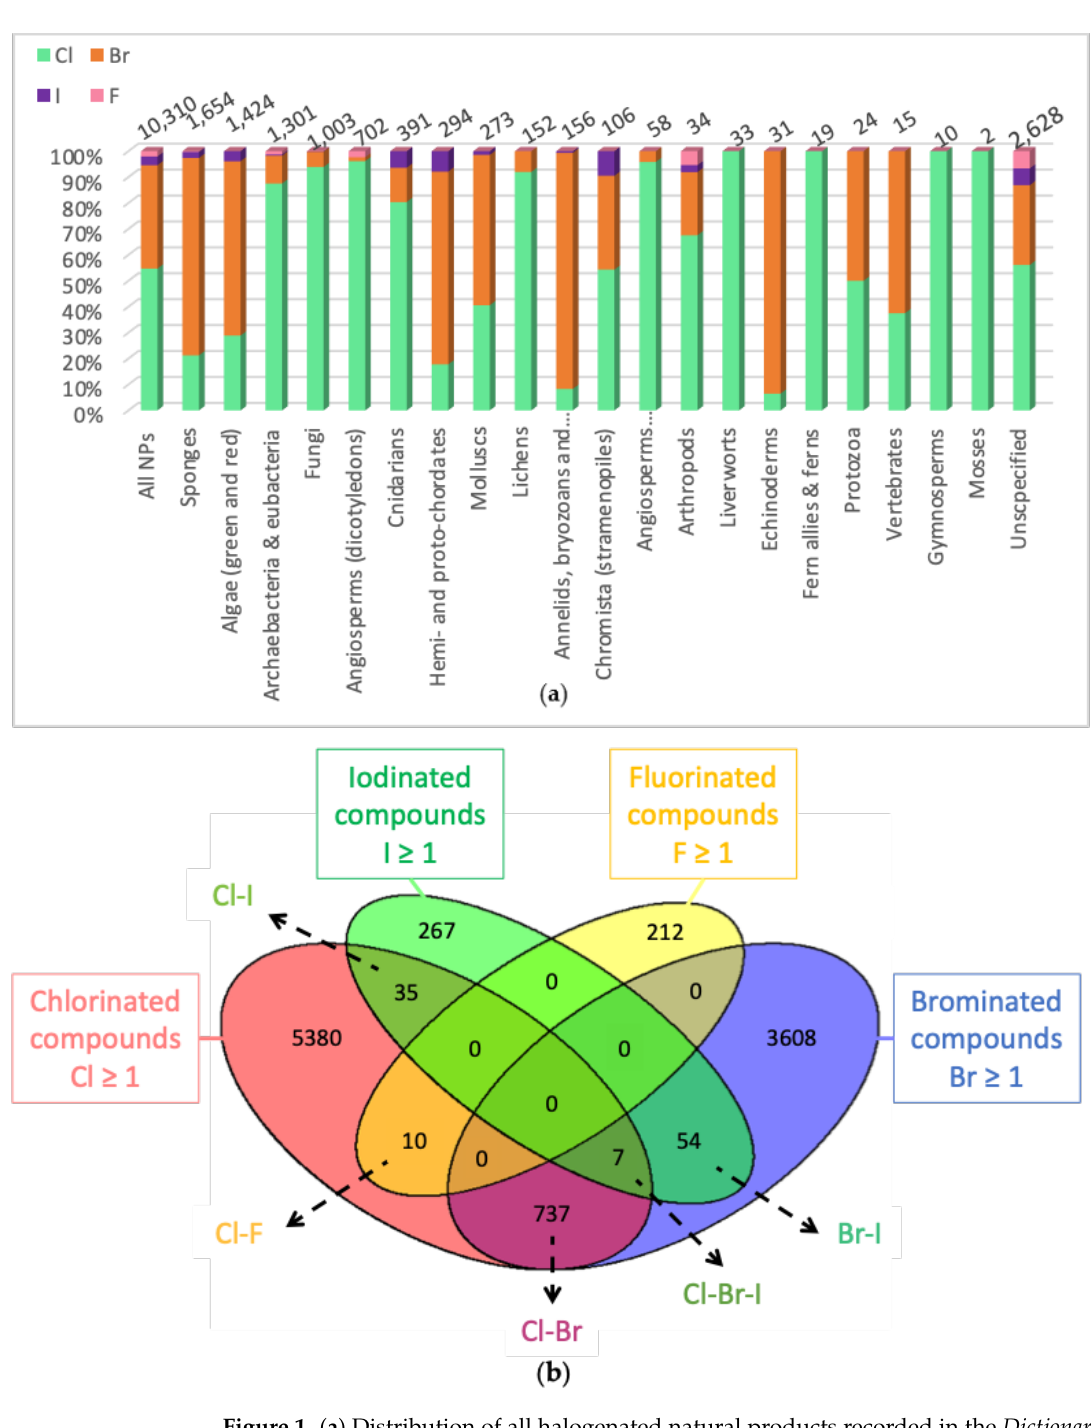
Figure 1. ( a ) Distribution of all halogenated natural products recorded in the Dictionary of Natural Products in March 2021 ( n = 10,310). The compounds were classified according to their clade. NPs in green contain at least one Cl, in orange at least one Br, in purple at least one I, and in pink at least one F. ( b ) Venn diagram of halogen distribution for all the halogenated natural products recorded in the DNP.